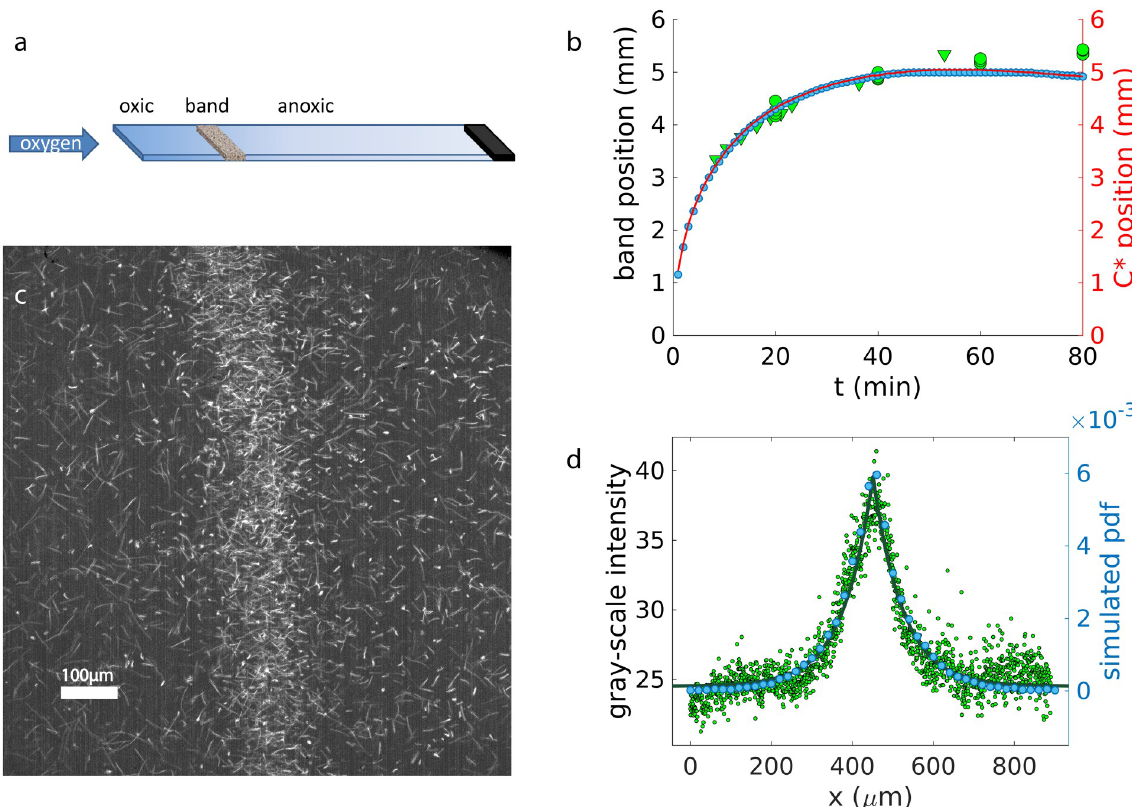
Fig 7. Capillary experiments and simulations. a) Scheme of a capillary experiment: a capillary is filled with bacteria; one end of the capillary is sealed, the other is open to the flow of oxygen. The bacteria accumulate at the preferred oxygen concentration, forming a band. b) Experimental band position over time (green data points) for wild type (WT) axial bacteria (optical density OD = 0.1, 5 repetitions, two different days— triangles and circles), with an antiparallel magnetic field of 50 μ T, compared to the simulated band position (blue data points) under the same conditions. The red line represents the position of the preferred concentration position as obtained from the simulation. c) Standard deviation of 100 frames (1 s) of a video of the band recorded at 100 fps and 10x magnification (WT OD = 0.1 antiparallel 50 μ T). d) The gray-scale values are averaged along the y coordinate of Fig. c), giving the experimental density profile of the band (green data points). The green line represents the Laplace fit (decay length 73 μm ). The simulated probability density function (pdf) n bin = n tot at equilibrium is represented by the blue bacteria bacteria data points (decay length 75 μm